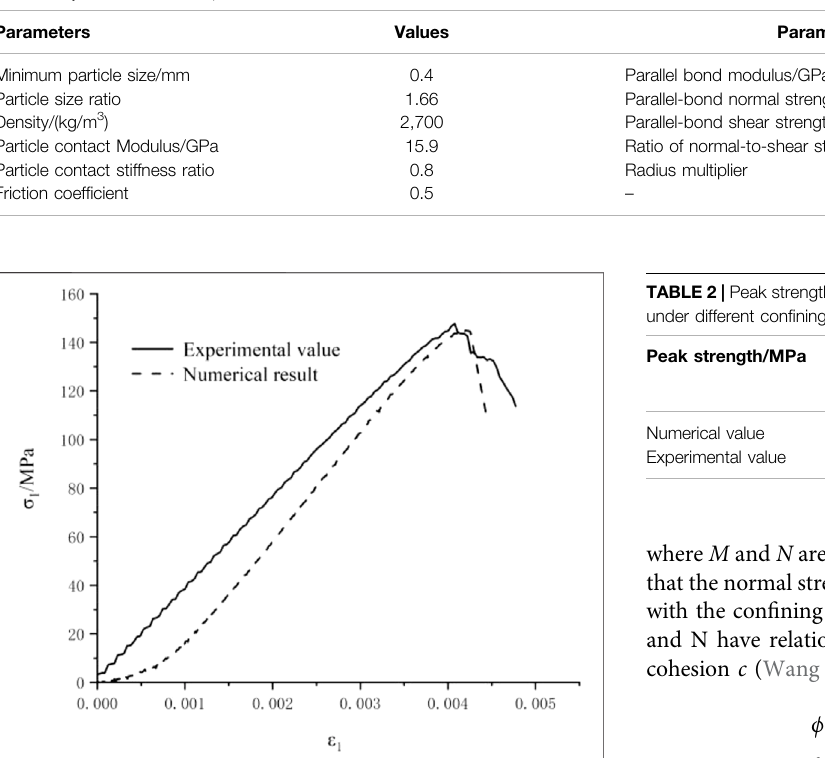
TABLE 1 | Micromechanical parameters of numerical model.